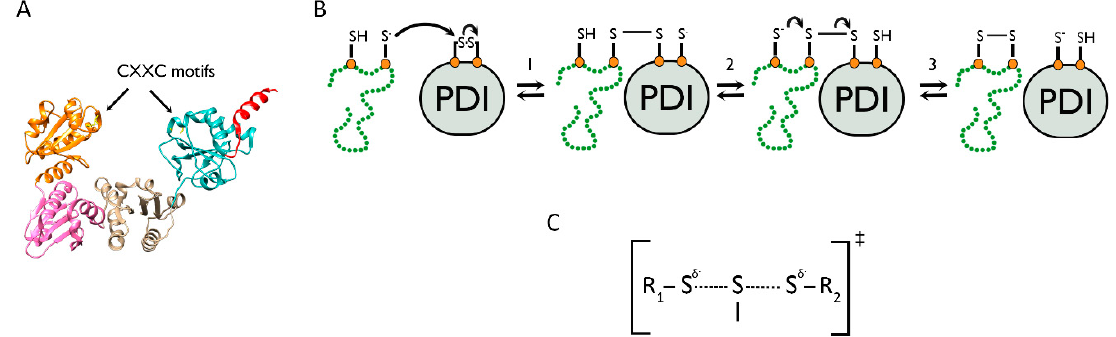
Figure 4. The mechanism of thiol–disulfide exchange in protein disulfide isomerase (PDI)-catalysed disulfide formation. ( A ) Ribbon diagram representing the 3D structure of PDI (PDB 2B5E), which contains four thioredoxin domains. The locations of the CXXC motifs are highlighted. ( B ) The reaction mechanism for thiol–disulfide exchange between a substrate and PDI, in which PDI oxidises the substrate and in turn becomes reduced. ( C ) The linear trisulphur transition state that forms during the S N 2 reactions at steps 1 and 3 as shown in ( B ).